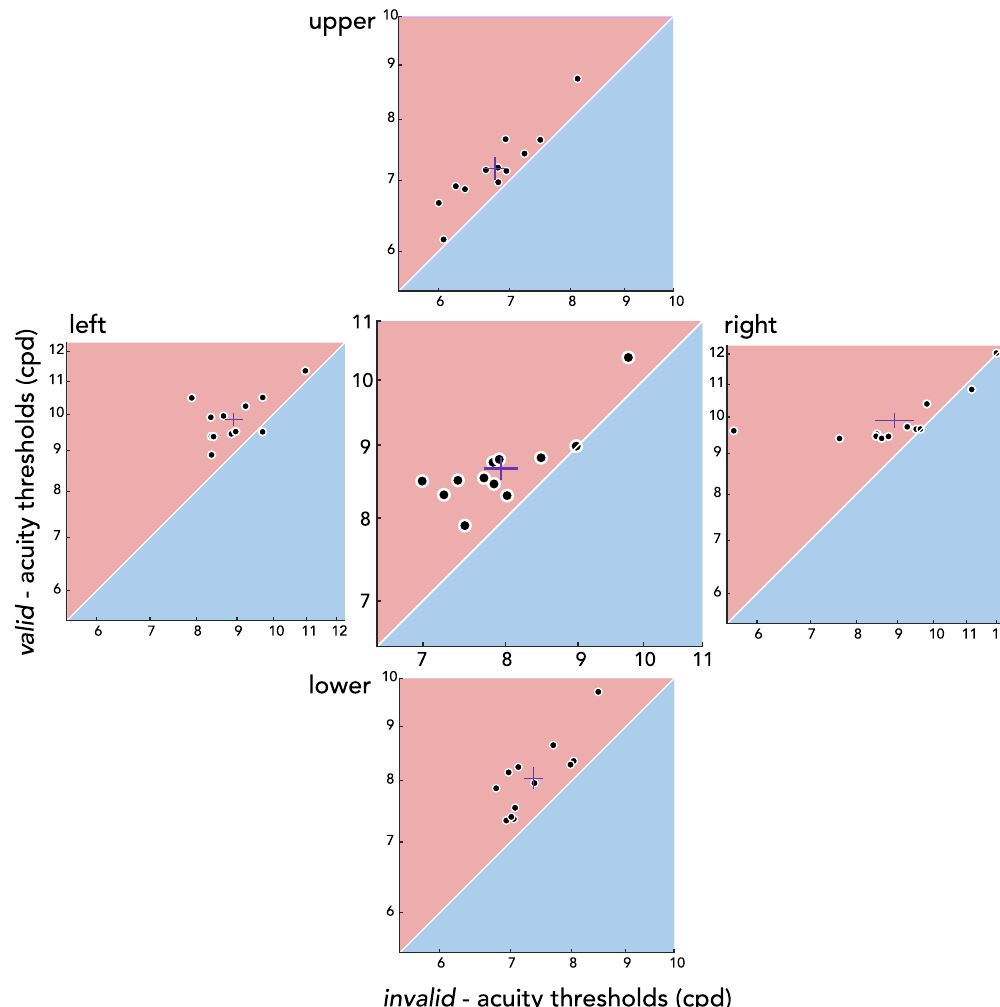
Figure 3. Individual participant’s presaccadic acuity. Acuity thresholds for each location (outer plots) and averaged across locations (center plot). Thresholds for the valid condition (y-axis) are plotted against the invalid condition (x-axis), and both axes are in log scale. Red lines depict mean ± 1 SEM. Note that the range plotted differs between locations, to account for visual field